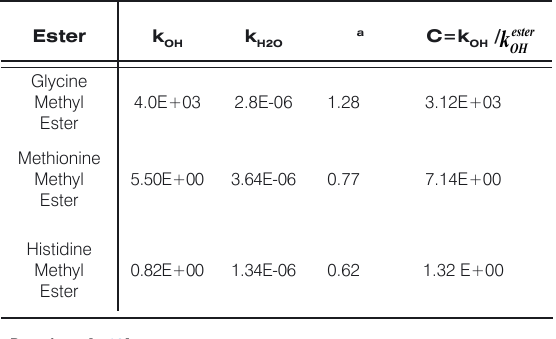
Table 3. Hydrolysis data (dm 3 mol -1 s -1 ) of [Pd(pip)(ester)] 2+ at 25°C and 0.1 M ionic